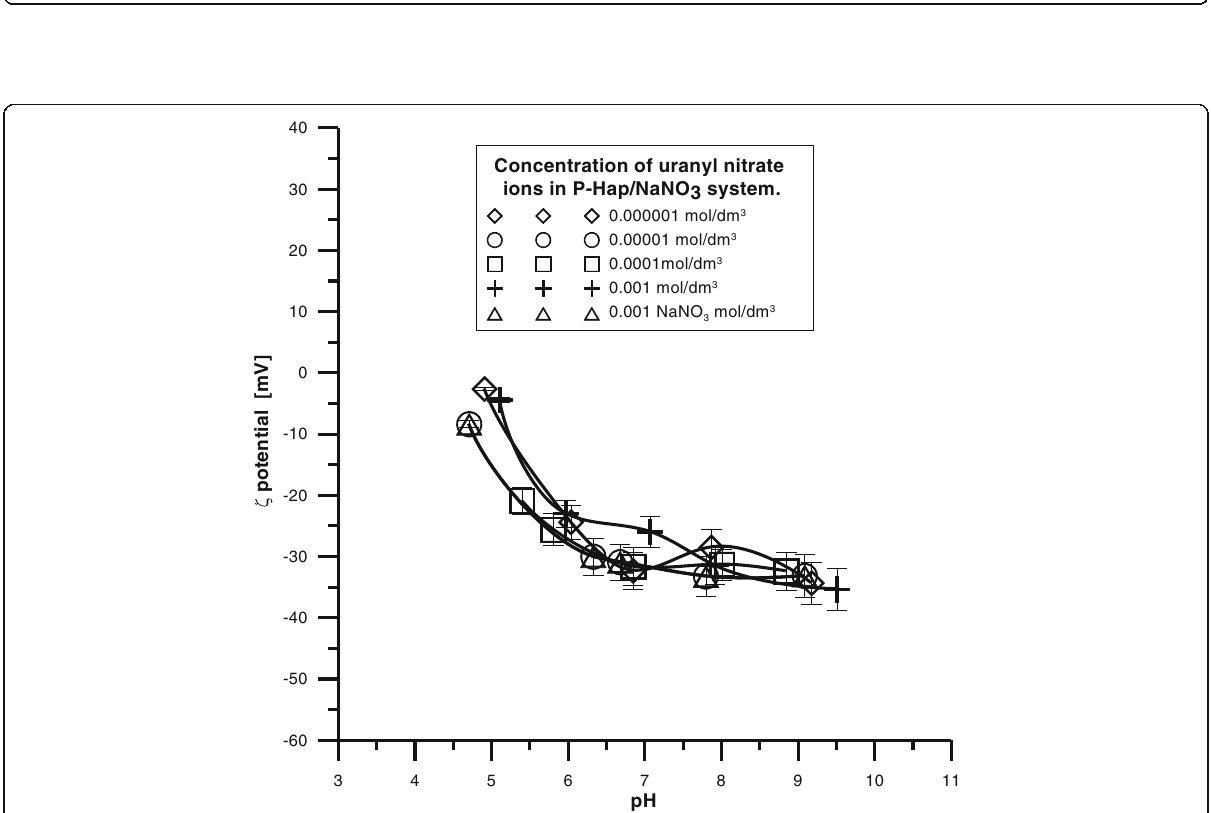
Fig. 9 The zeta potential as a function of pH for the nano-hydroxyapatite (HAP) dispersed in NaNO 3 solution with different concentrations of U(VI)